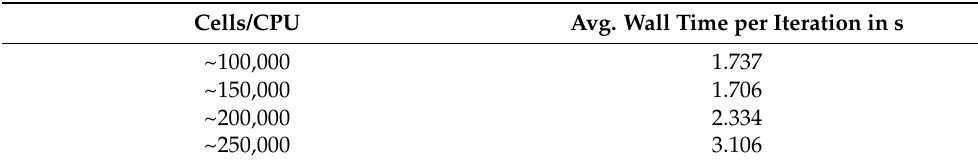
Table 1. Influence of the cell/CPU ratio on the avg. wall time per